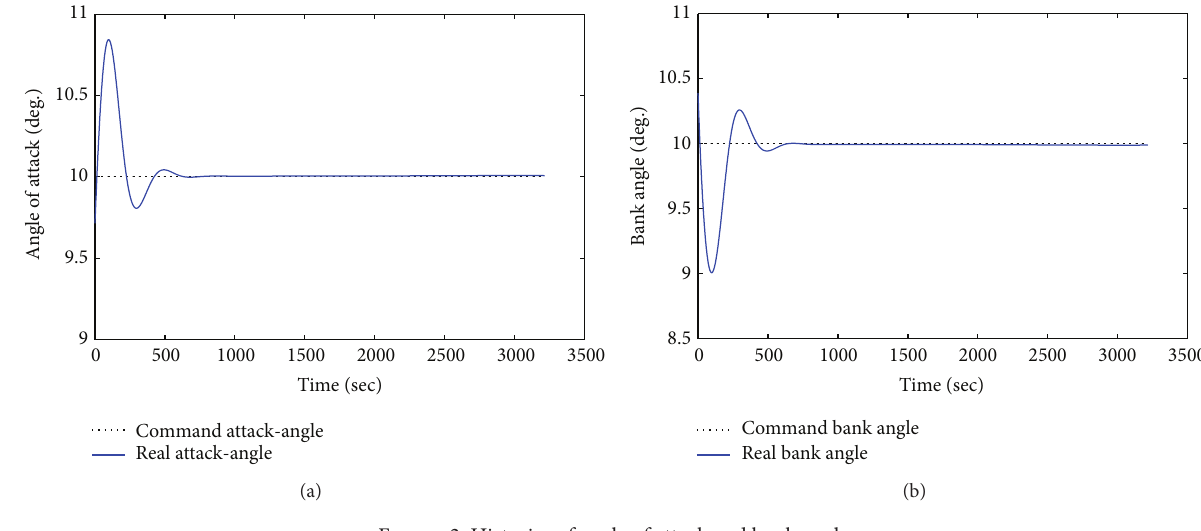
Figure 2: Histories of angle of attack and bank